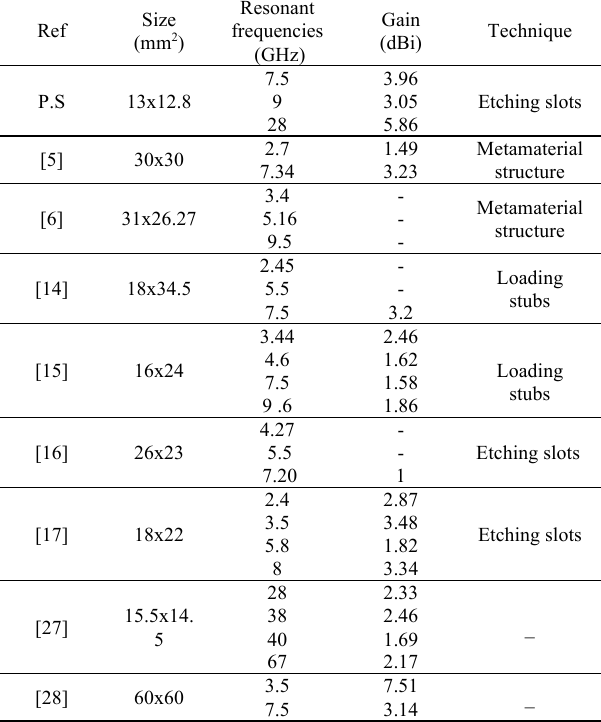
TABLE I. Comparison of the Proposed Antenna and Already Reported Antenna. Size Ref (mm 2